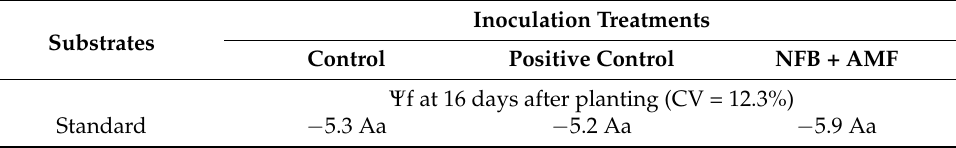
Table 7. Leaf water potential ( Ψ f in bar) at 16, 28, 37, and 38 days after planting Samanea saman when there was an interaction between the factors: substrates and inoculation patterns.